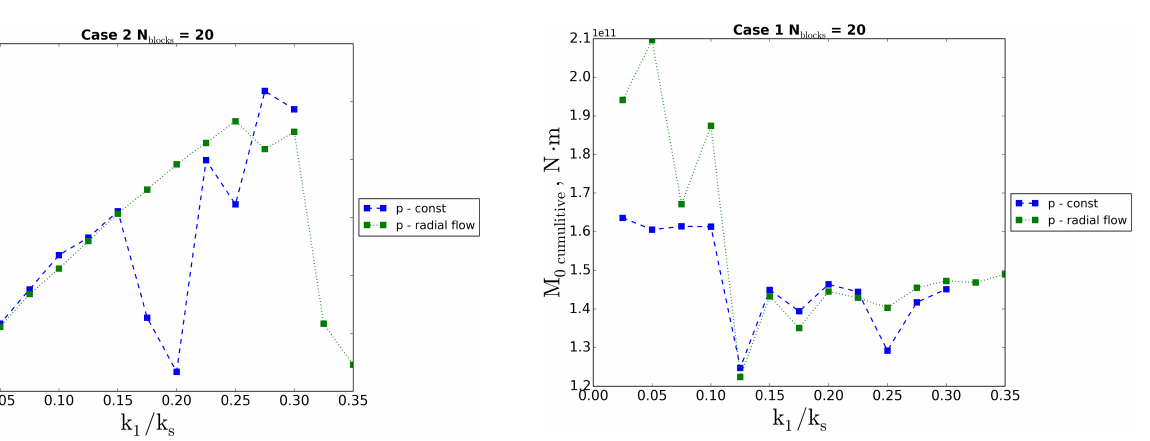
Figure 19. The event maximum seismic moment dependence on the stiffness of the interblock link.